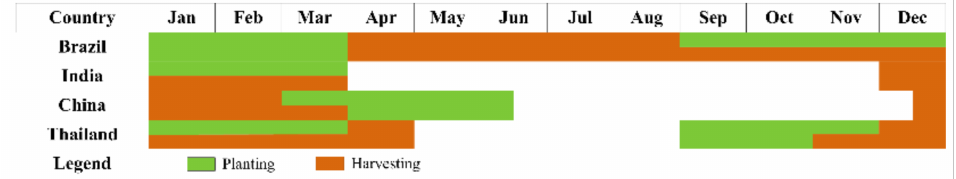
Figure 2. Sugarcane crop cycle of four main sugar producing countries.